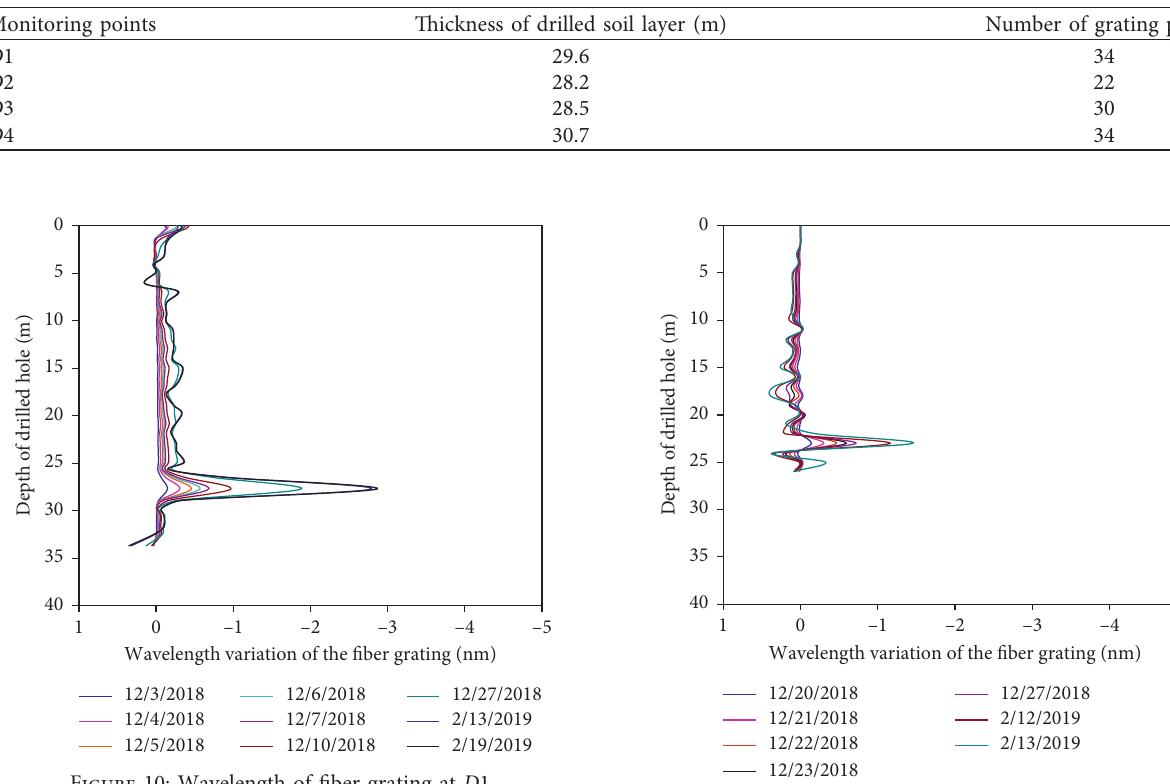
Table 1: Monitoring hole information of fiber grating monitoring.